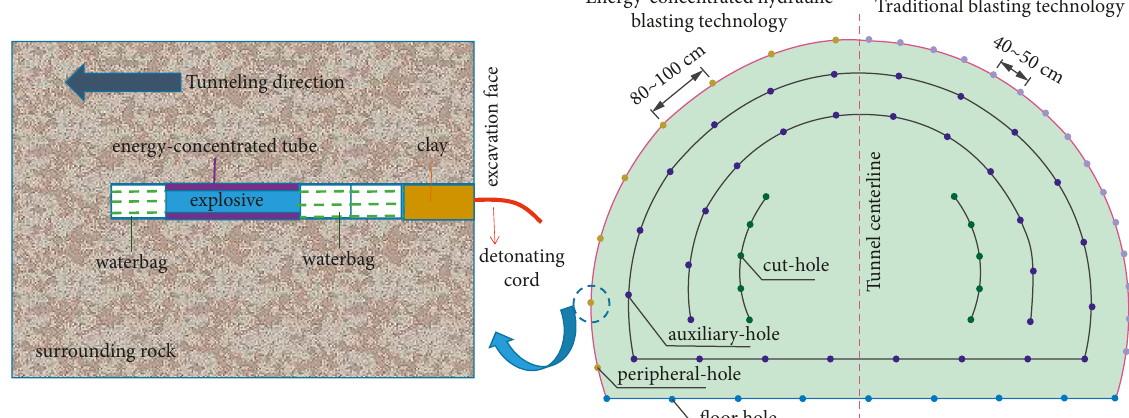
Figure 7: Charge structure of ECHBT.